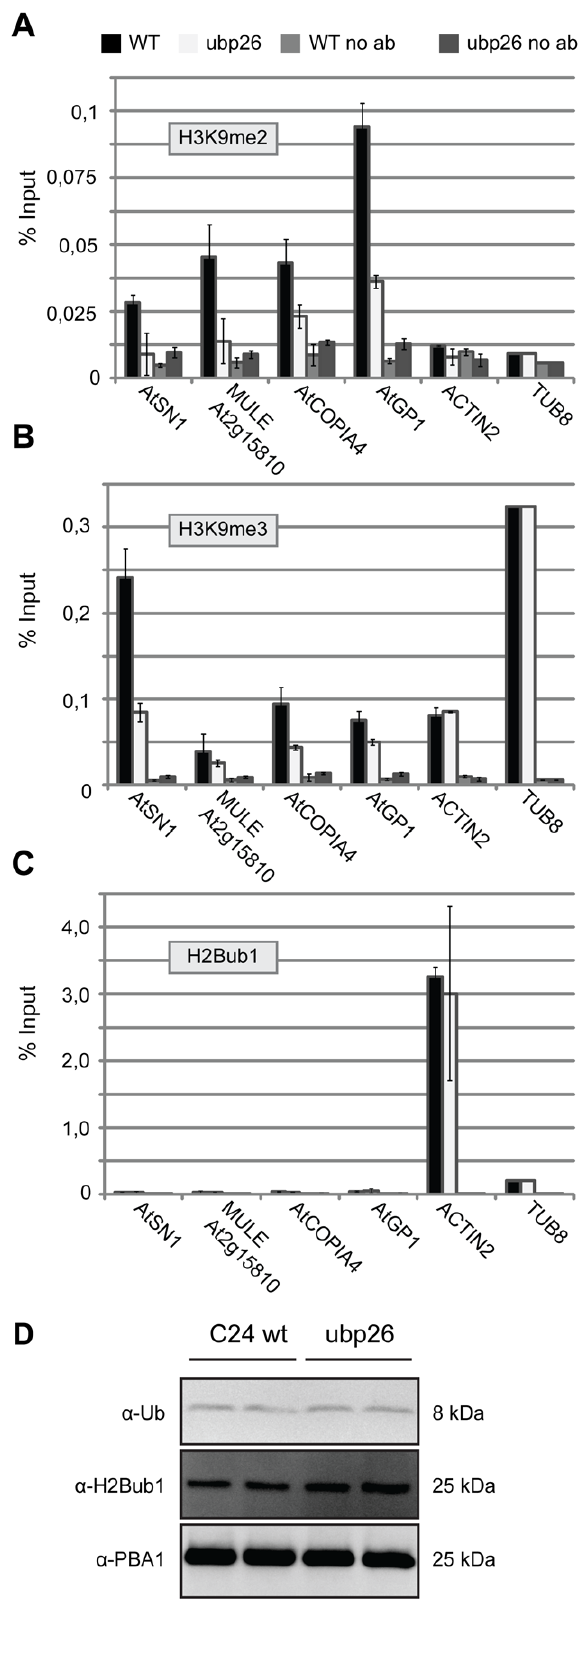
Figure 6. UBP26 directs H3K9me2 and H3K9me3 on transpo- son sequences. ChIP analysis of ubp26-1 lines using antibodies against (A) H3K9me2, (B) H3K9me3 or (C) H2Bub1. DNA levels from the ChIP experiments relative to the input reactions were quantified using real time PCR and normalized to TUB8 . The bars represent the average of two independent biological replicates. (D) Western blot of nuclear proteins isolated from ubp26-1 and wild type, probed with antibodies against ubiquitin (ub), H2Bub1 or PBA1 (loading